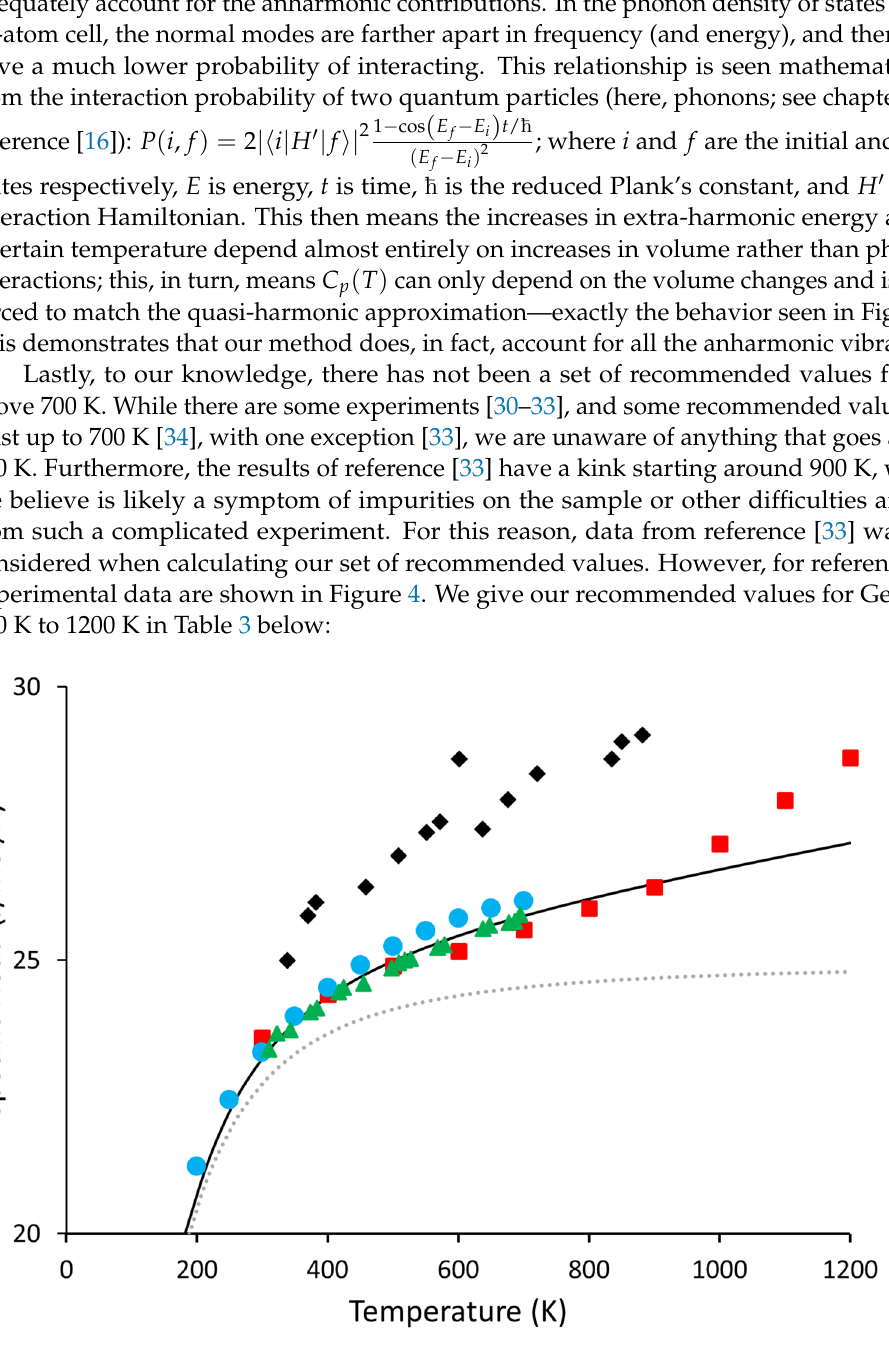
Figure 4. Shown above are all the experimental values of Ge that we are aware of. Blue circles are taken from [32], the red squares are taken from [33], the black diamonds are taken from reference [31], and the green triangles are the same as those in Figure 3, from [30]. The black line and the dotted grey line are the C p ( T ) and C v ( T ) from this work,